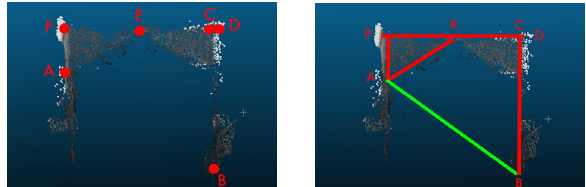
Figure 14. Feature points and distances in the final point cloud of the pavilion of Les Halles.